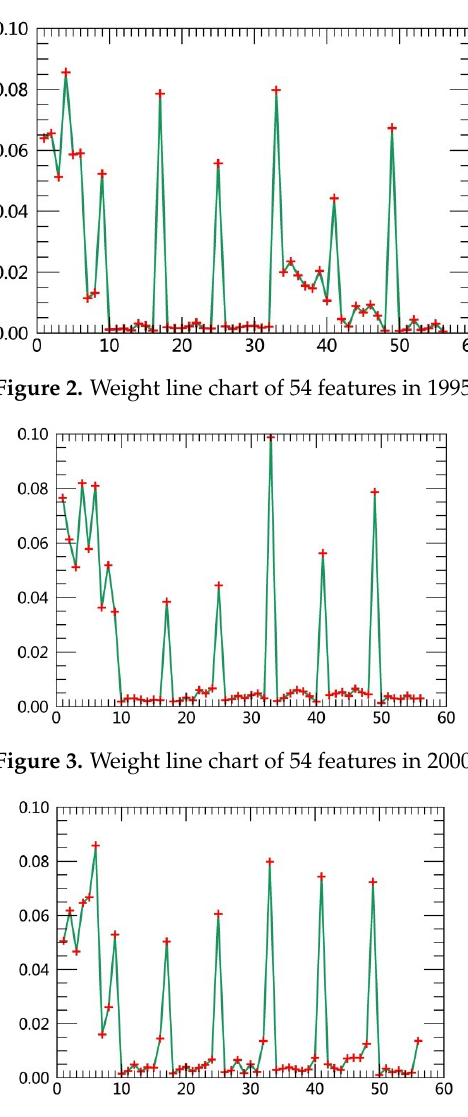
Figure 4. Weight line chart of 54 features in 2005.